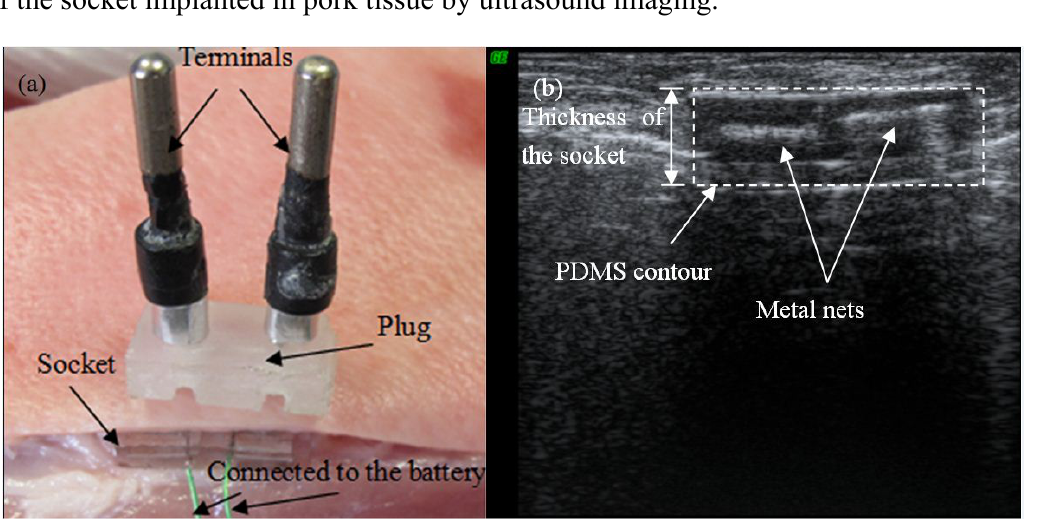
Figure 10. The implantation of device in pork tissue. ( a ) The picture of the device implanted in pork tissue. ( b ) The picture of the device implanted in pork tissue by ultrasound